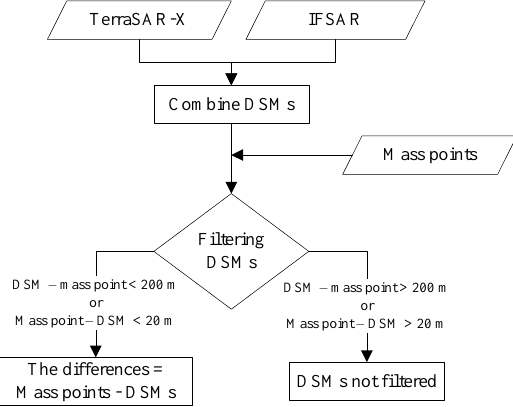
Figure 3. The algorithm of the DSM filtering based on a threshold value of differences between DSM and masspoints.